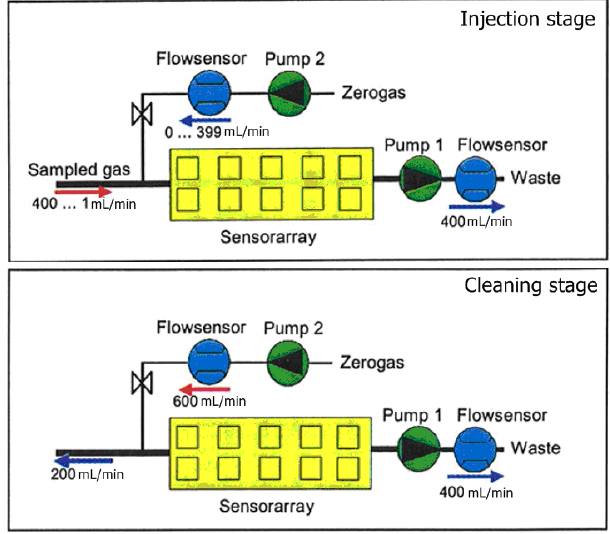
Figure 2. Schematic diagrams of the gas flow of PEN3 during the electronic nose